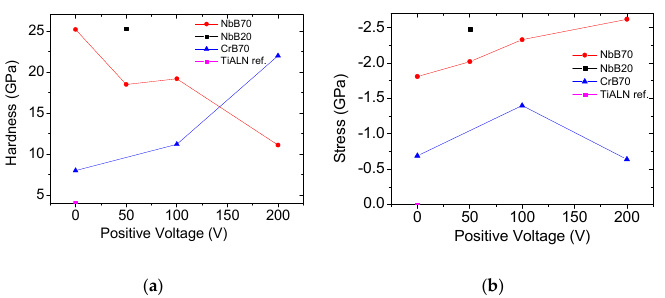
Figure 5. Nanoindentation hardness ( a ) and accumulated stress ( b ) as a function of the Nb, Cr positive accelerating voltage.